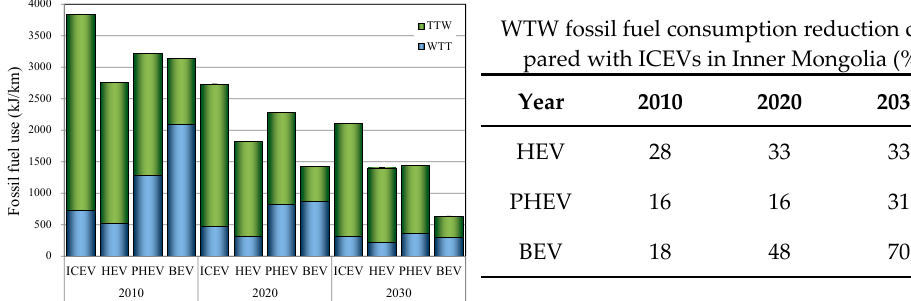
Figure 8. WTW fossil fuel consumption of ICEVs/HEVs/PHEVs/BEVs in Inner Mongolia. WTW fossil fuel consumption reduction com- pared with ICEVs in Sichuan (%).